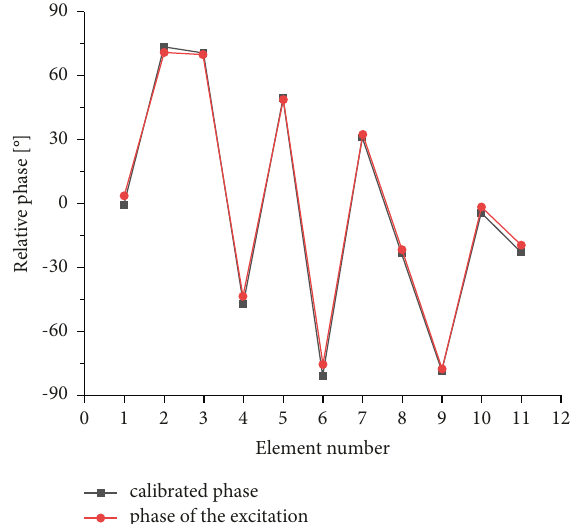
Figure 9: Relative phase comparison between calibrated result and excitation.